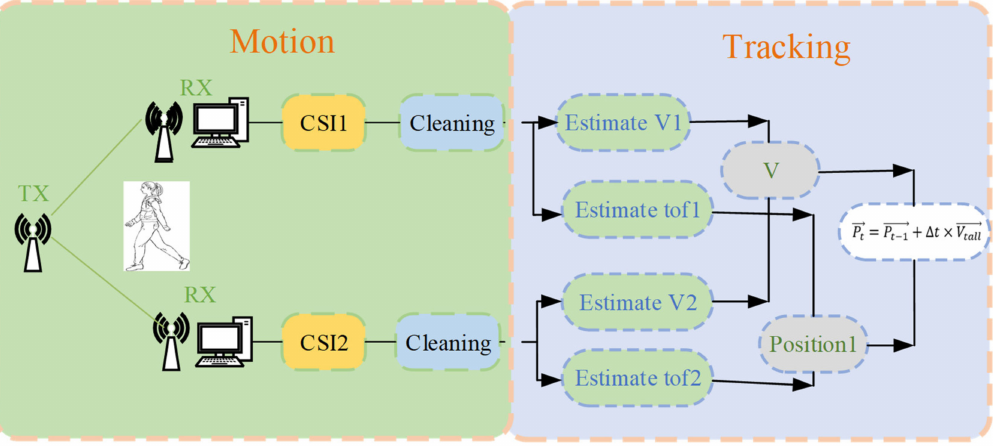
Figure 2. Flow chart of